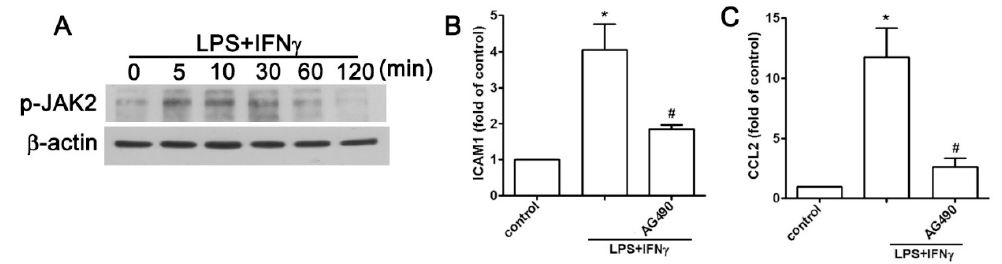
Figure 2. JAK2 pathway is involved in the pro-inflammatory stimuli-associated expression of ICAM1 and CCL2 in human AF cells. ( A ) Cells were treated with LPS plus IFN γ for 5, 10, 30, 60, or 120 min, and phosphorylated JAK2 expression was determined using western blot analysis. Cells were treated with the JAK2 inhibitor AG 490 (10 µ M) for 30 min and with LPS plus IFN γ for another 6 h, and the expression of cell surface ICAM1 ( B ), and CCL2 ( C ) were determined using flow cytometry and real-time PCR analysis, respectively. Quantitative data are presented as the mean ± SEM (representative of n = 3). * p < 0.05 compared with the control group. # p < 0.05 compared with the LPS plus IFN γ